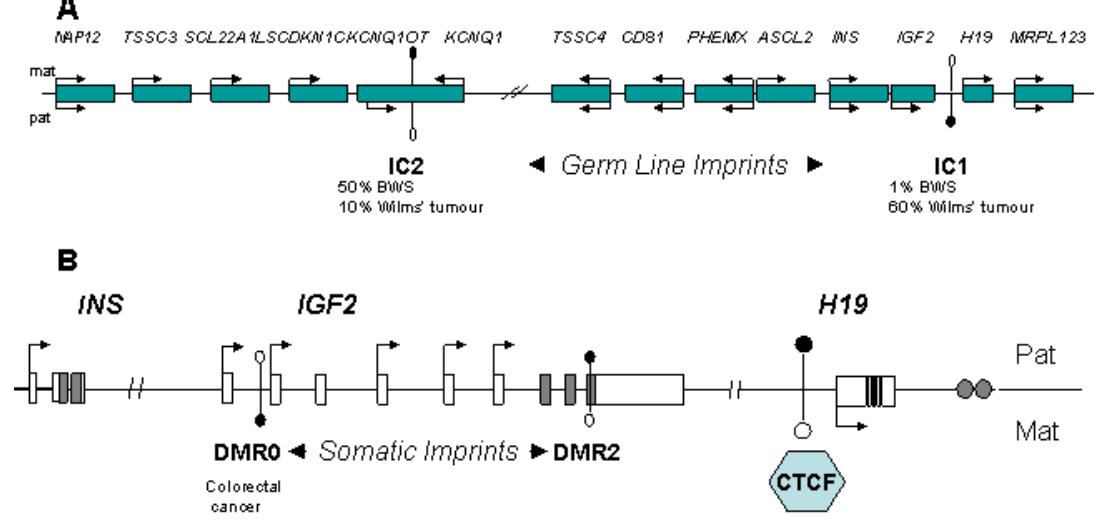
FIGURE 2. Germline and somatic imprints that are associated with the cluster of imprinted genes on chromosome 11p15.5. (A) Genes within the cluster at 11p15.5, with arrows depicting direction of transcription for maternal and paternal expression above and below the line. Germline imprints IC1 and IC2 (imprinting control centres 1 and 2) are shown as open and filled lollipops corresponding to unmethylated and methylated regions. IC1 (also sometimes referred to H19 DMR, DMD, and ICR) regulates H19 and IGF2 expression, while IC2 (also referred to Lit1 DMR and KvDMR1) regulates TSSC3 , SLC22A1LS , CDKNIC , KCNQ1OT1 , and KCNQ1. (B) The IGF2-H19 region showing INS, IGF2, and H19, the germline DMR; IC1 depicted as lollipops as above and the somatic DMRs within IGF2 depicted as slightly smaller lollipops. Methylation at IC1 limits the binding of CTCF to the unmethylated maternal allele and prevents IGF2 from gaining access to the enhancers (circles) downstream of H19 . Changes in methylation at germline imprints have been associated with LOI of IGF2 and other imprinted genes in BWS and childhood tumours such as Wilms’ tumour, while in adult cancers, changes in methylation at the somatic DMR0 in IGF2 have been associated with LOI of IGF2